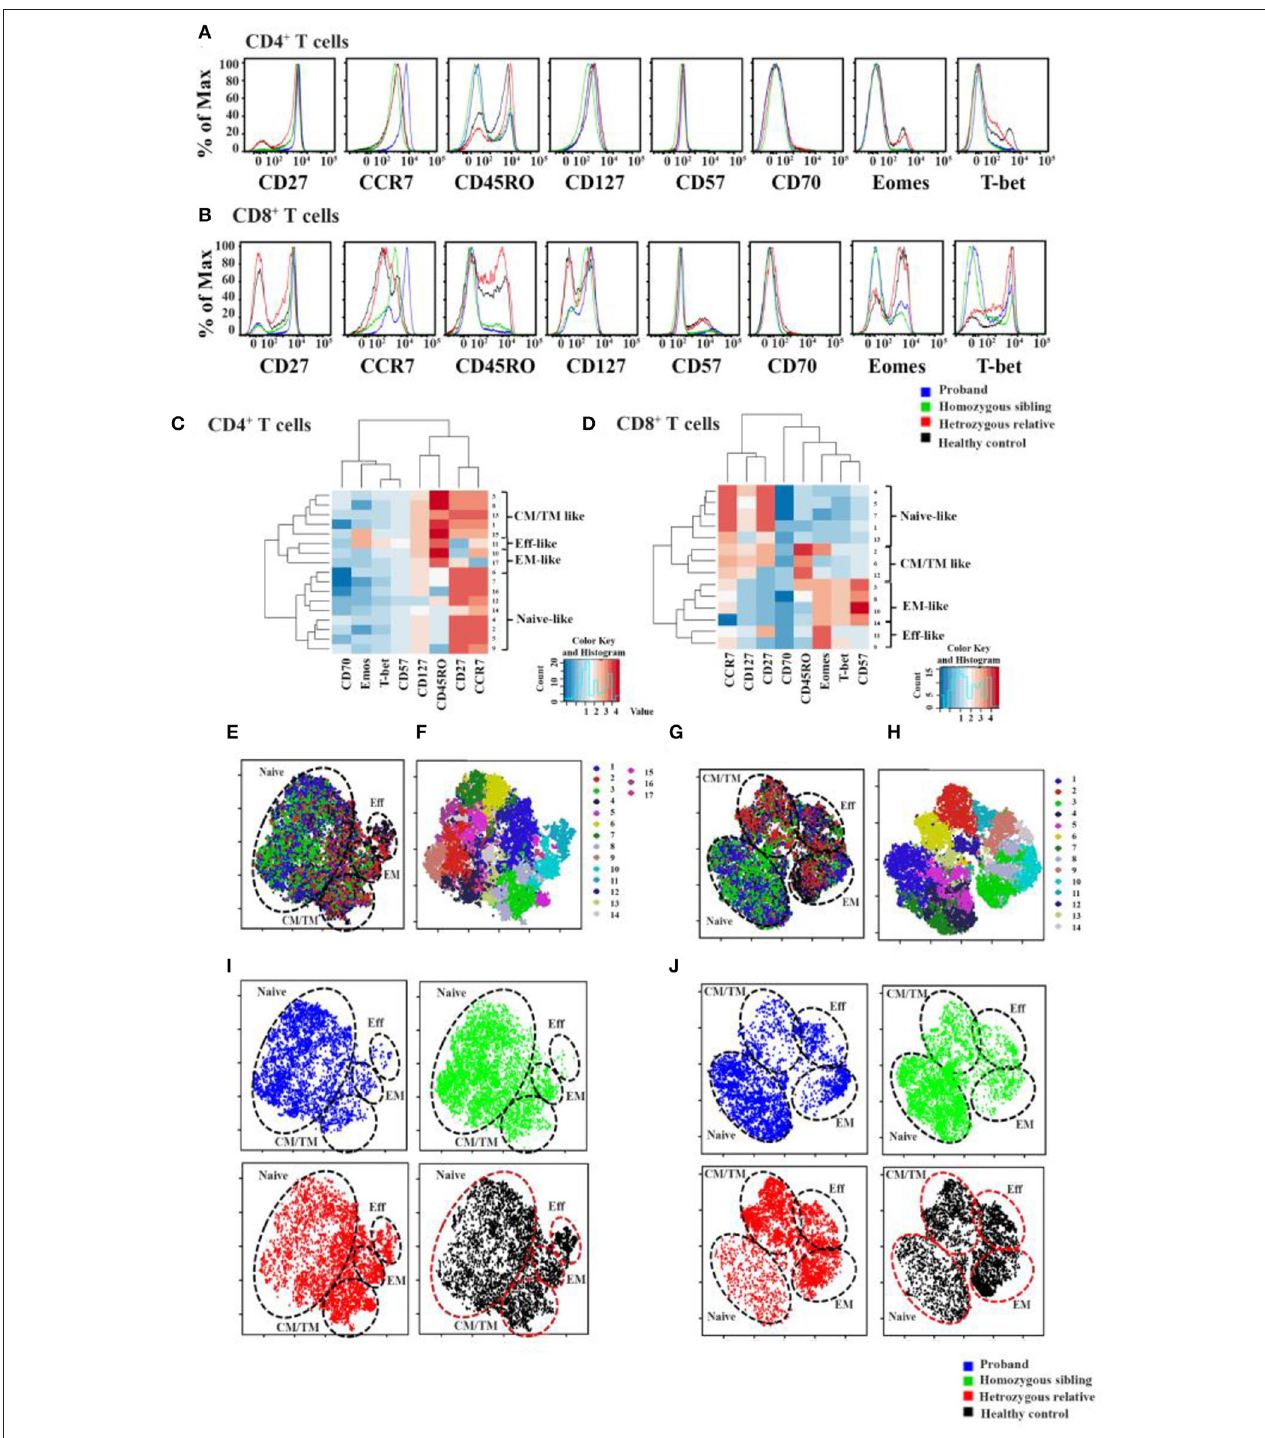
FIGURE 2 | Immunologic markers of cells in CD70-deficient family. Histogram overlays of all differentiation markers (CCR7, CD27, CD57, CD70, CD127, CD45RO, Eomes, and T-bet) for CD4 + (A) and CD8 + cells (B) in two homozygous patients, a heterozygous relative father, and a healthy control. Using an automated density-based algorithm called PhenoGraph, 17 CD4 + T-cell (C) and 14 CD8 + T-cell (D) subclusters were identified based on the intensity of CCR7, CD27, CD57, CD70, CD127, CD45RO, Eomes, and T-bet expression. Hierarchical Spearman clustering was performed to delineate the relationship between the different T-cell clusters using dendograms and heat maps. The relationships between different clusters were identified as naive-, central/transitional memory- (CM/TM-), effector